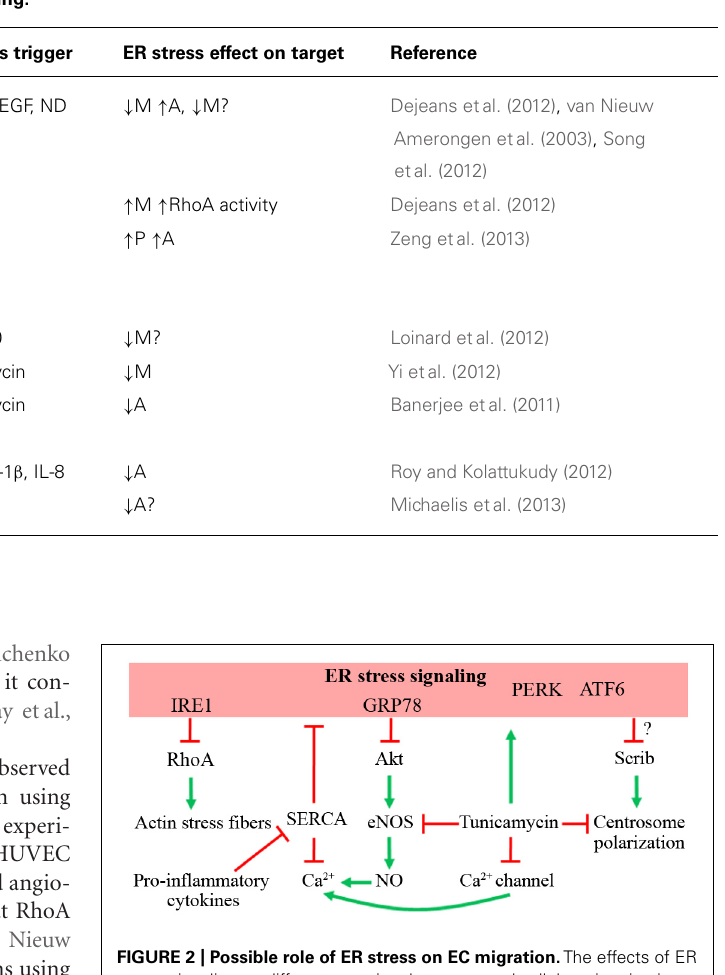
Table 1 | Putative migration-related targets of ER stress signaling.